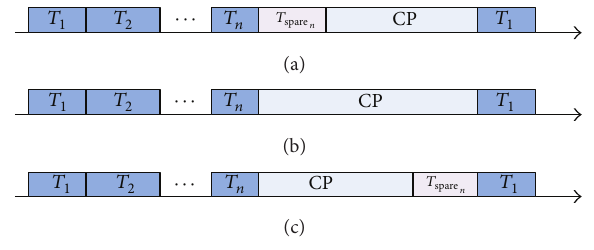
Figure 5: Example of 𝑇